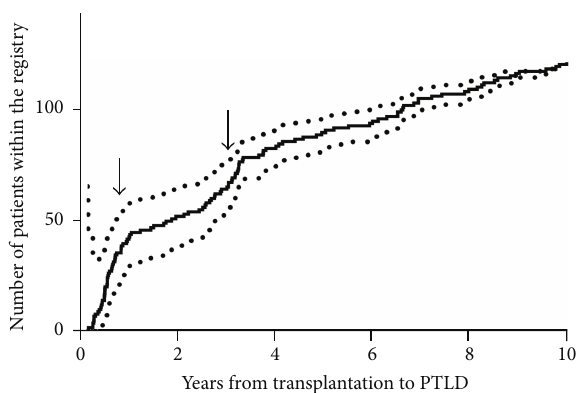
Figure 1: Time from transplantation to diagnosis of PTLD of 127 patients in the German Ped-PTLD registry. Kaplan-Meyer curve (continuous line) and 95% confidence intervals (dotted curve). Note the rapid increase within the first year and another in the third